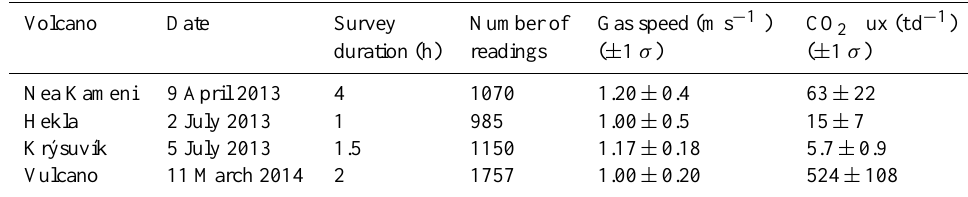
Table 1. CO 2 fluxes (in td − 1 ) and standard deviation (1 σ ) calculated in this study. The survey duration (in h), the number of CO 2 readings (with R 2 > 0.95), and the plume vertical transport speed (in ms − 1 ) are also given for each site. Volcano Date Survey Number of duration (h)